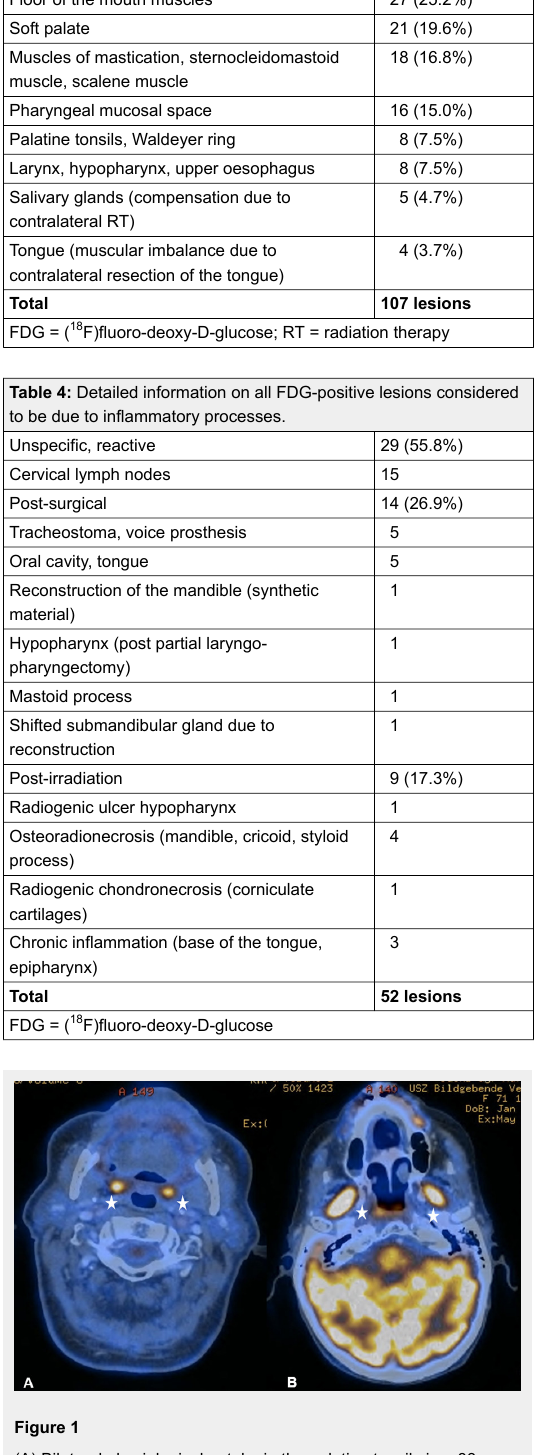
(A) Diffuse bilateral uptake in the thyroid without any morphological correlate in a 67-year old patient with no clinical, ultrasonographical or laboratory signs of thyroid dysfunction. (B) The same patient with corresponding probable reactive